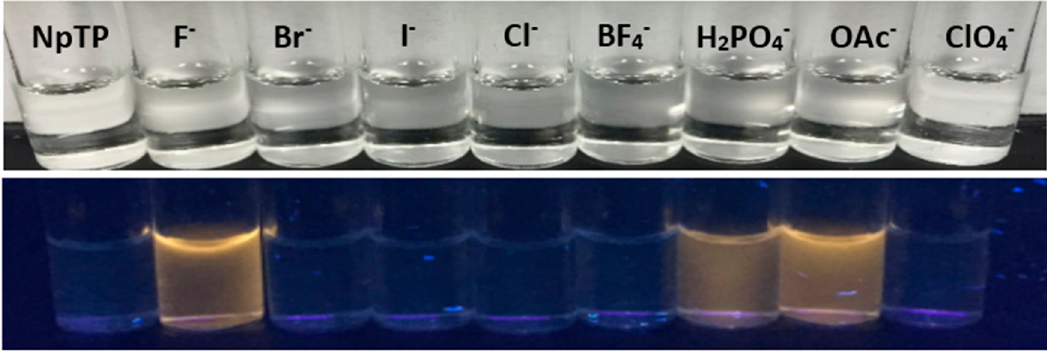
Figure 12. Color changes of NpTP under a UV lamp of long wavelength (365 nm) upon addition of ~2 × 10 − 2 M of anions to ~1 × 10 − 3 M sensor in